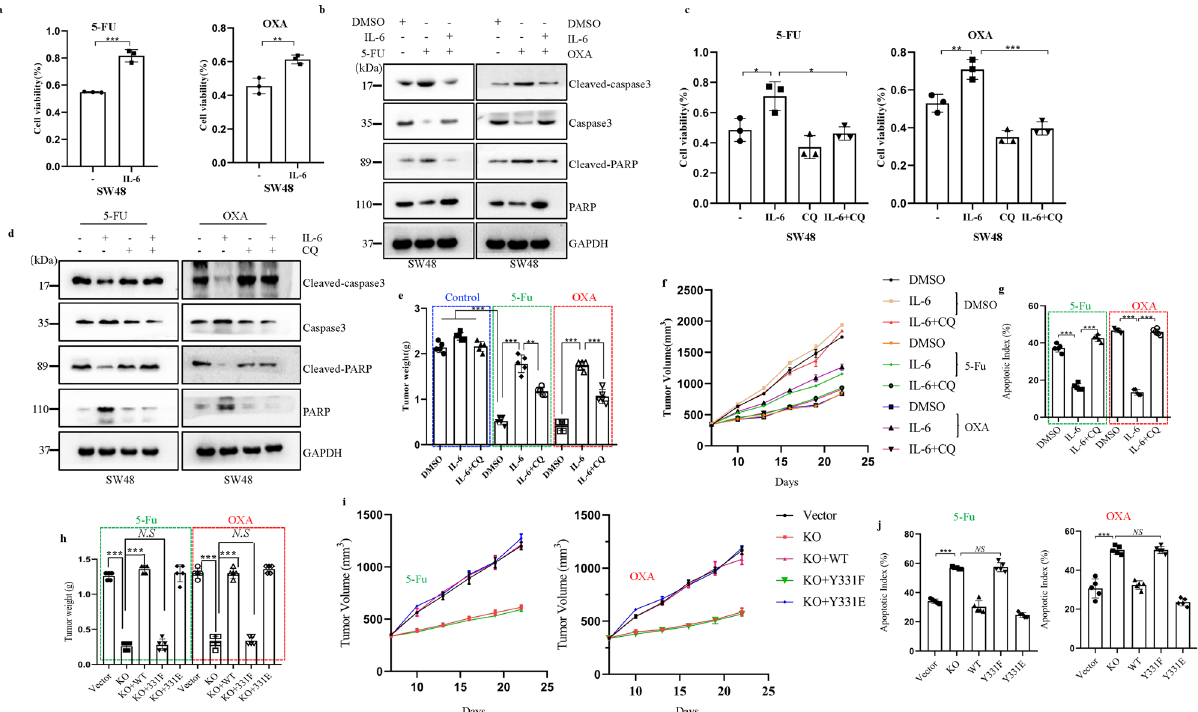
Fig. 5 IL-6-induced BECN1 Y333 phosphorylation promotes cancer chemotherapy resistance. a CCK-8 assays for cell viability of SW48 cells separately pretreated with DMEM or IL-6 (20 ng/ml) for 8 h in the presence of DMSO, 5-Fu (800 μ M), or OXA (100 μ M) for 36 h. ** P < 0.01, *** P < 0.001 ( n = 3 independent experiments). b Western blot analyses for cleaved caspase-3 and cleaved PARP1 in SW48 cells separately pretreated with DMEM or IL-6 (20 ng/ml) for 8 h in the presence of DMSO, 5-Fu (800 μ M) or OXA (100 μ M) for 36 h ( n = 3 independent experiments). c CCK-8 assays for cell viability of SW48 cells separately pretreated with DMEM or IL-6 (20 ng/ml) for 8 h in the presence of CQ (25 μ M), 5-Fu (800 μ M) or OXA (100 μ M) for 36 h. * P < 0.05, ** P < 0.01, *** P < 0.001 ( n = 3 independent experiments) d Western blot analyses for cleaved caspase-3 and cleaved PARP1 in SW48 cells separately pretreated with DMEM or IL-6 (20 ng/ml) for 8 h in the presence of CQ (25 μ M), 5-Fu (800 μ M), or OXA (100 μ M) for 36 h. ( n = 3 independent experiments). e In vivo CRC xenografts derived from CT26 cells were treated with IL-6, 5-Fu, or OXA. Quanti fi cation of tumor weights from the different CRC xenografts is shown. ** P < 0.01, *** P < 0.001. f Tumor volumes at the experimental endpoint were quanti fi ed in CT26 cell xenografts. g The apoptotic index was quanti fi ed for the different CRC xenografts. ** P < 0.01, *** P < 0.001. h – j In vivo CRC xenografts derived from CT26 cells and CT26-Becn1-KO cells separately expressing a vector control (Vector), Becn1 WT, Becn1 Y3331F, or Becn1 Y3331 were treated with DMSO, 5-Fu or OXA. Tumor weights ( h ), tumor volumes ( i ), and apoptotic index ( j ) quanti fi ed at the experimental endpoint are shown ( n = 5 mice per genotype). ** P < 0.01, *** P < 0.001. NS not signi fi cant. In ( a , c , e , g , h and j ), the values are presented as the means ± SEM; p values (Student ’ s t test, two-sided) with control or different indicated groups are shown. Source data are provided in the Source Data fi